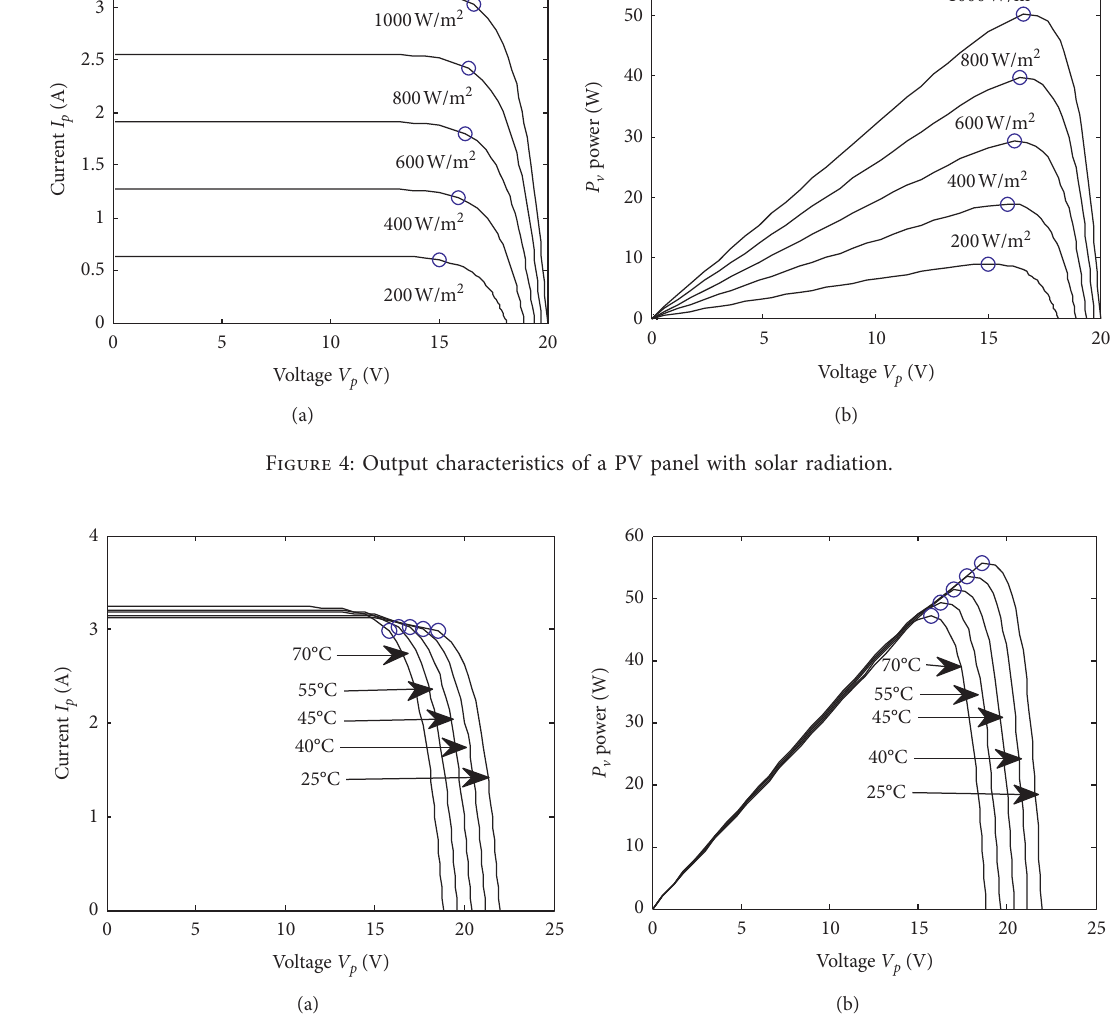
Figure 5: Output characteristics of a PV panel with junction temperature variation.